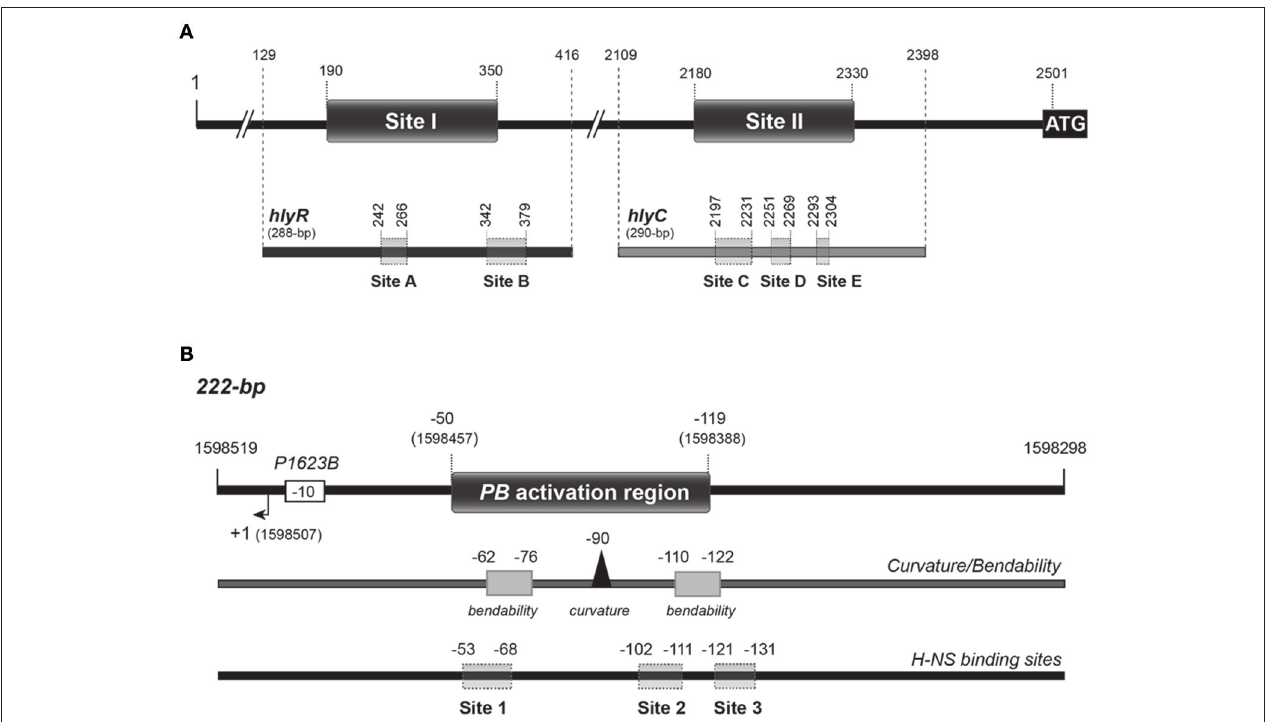
FIGURE 1 | Relevant features of the DNA fragments used as targets for H-NS-His and Mga Spn -His in this study. (A) The hly regulatory region of plasmid pHly152. The location of the two H-NS binding sites (sites I and II) defined by DNase I footprinting assays (Madrid et al., 2002) is indicated. Both sites are located upstream of the hlyC gene, the first gene of the hly operon. The ATG translation start codon of hlyC (coordinate 2501) and the coordinates of the hlyR (288-bp) and hlyC (290-bp) DNA fragments are shown in the upper part of the Figure. Shadowed boxes on the hlyR and hlyC DNA fragments (lower part of the Figure) represent the Mga Spn -His binding sites (sites A, B, C, D, and E) defined by DNase I footprinting assays in this study. (B) The pneumococcal 222-bp DNA fragment. It corresponds to the region spanning coordinates 1598298 and 1598519 of the R6 chromosome. The P1623B promoter and the corresponding transcription start site ( + 1) are indicated. This fragment contains the PB activation region (positions − 50 to − 119 relative to the transcription start site of the P1623B promoter) ( Solano-Collado et al., 2012). The PB activation region contains a peak of potential intrinsic curvature (arrowhead) that is flanked by regions of potential bendability (gray boxes) (Solano-Collado et al., 2013). The sites (sites 1, 2, and 3) recognized preferentially by H-NS-His on the 222-bp DNA fragment are shown (this work).